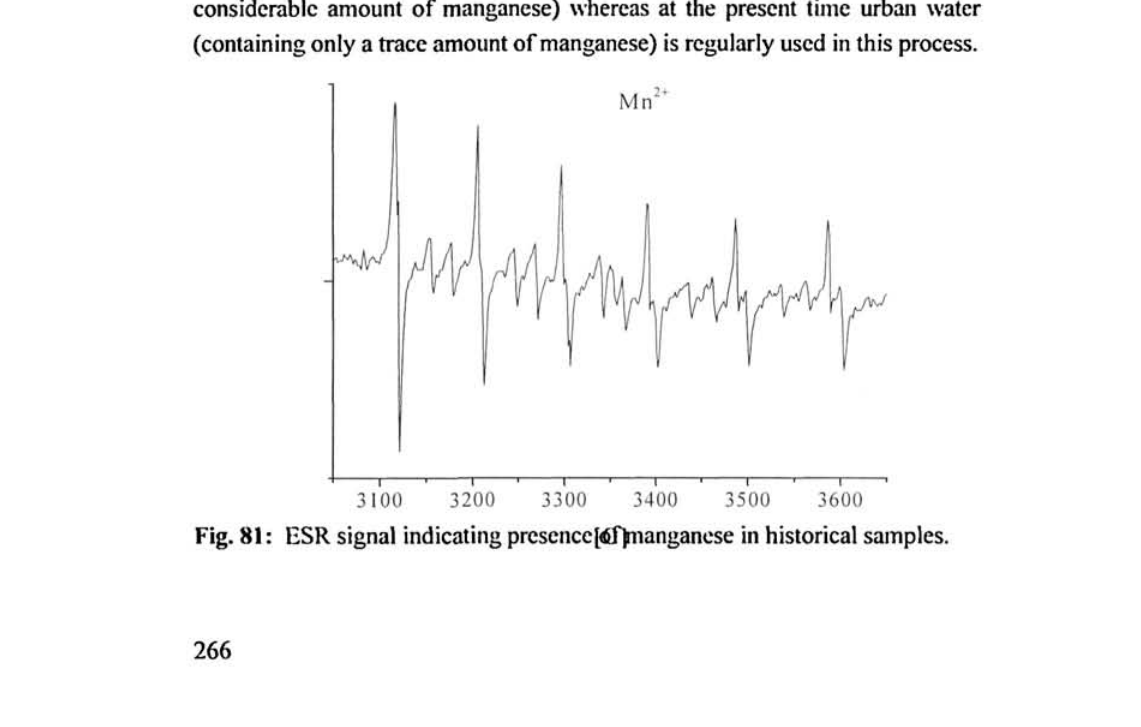
modern aged Mean ESR signal of modern and artificially aged parchment samples. Fig. 80: